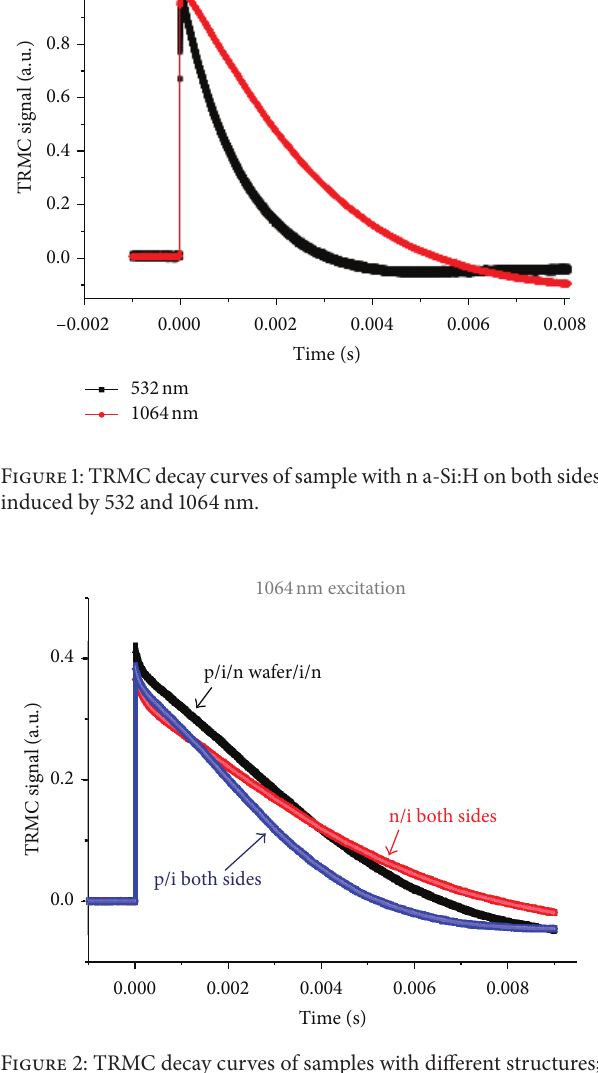
(Figure 2). The sample with the n a-Si:H/i a-Si:H passivated on both sides (sample a) indicated the longest decay time while the sample with the p a-Si:H/i a-Si:H on both sides (sample b) showed the shortest decay time.